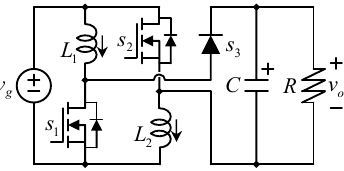
Figure 1. One of the boost-type topologies in [9].